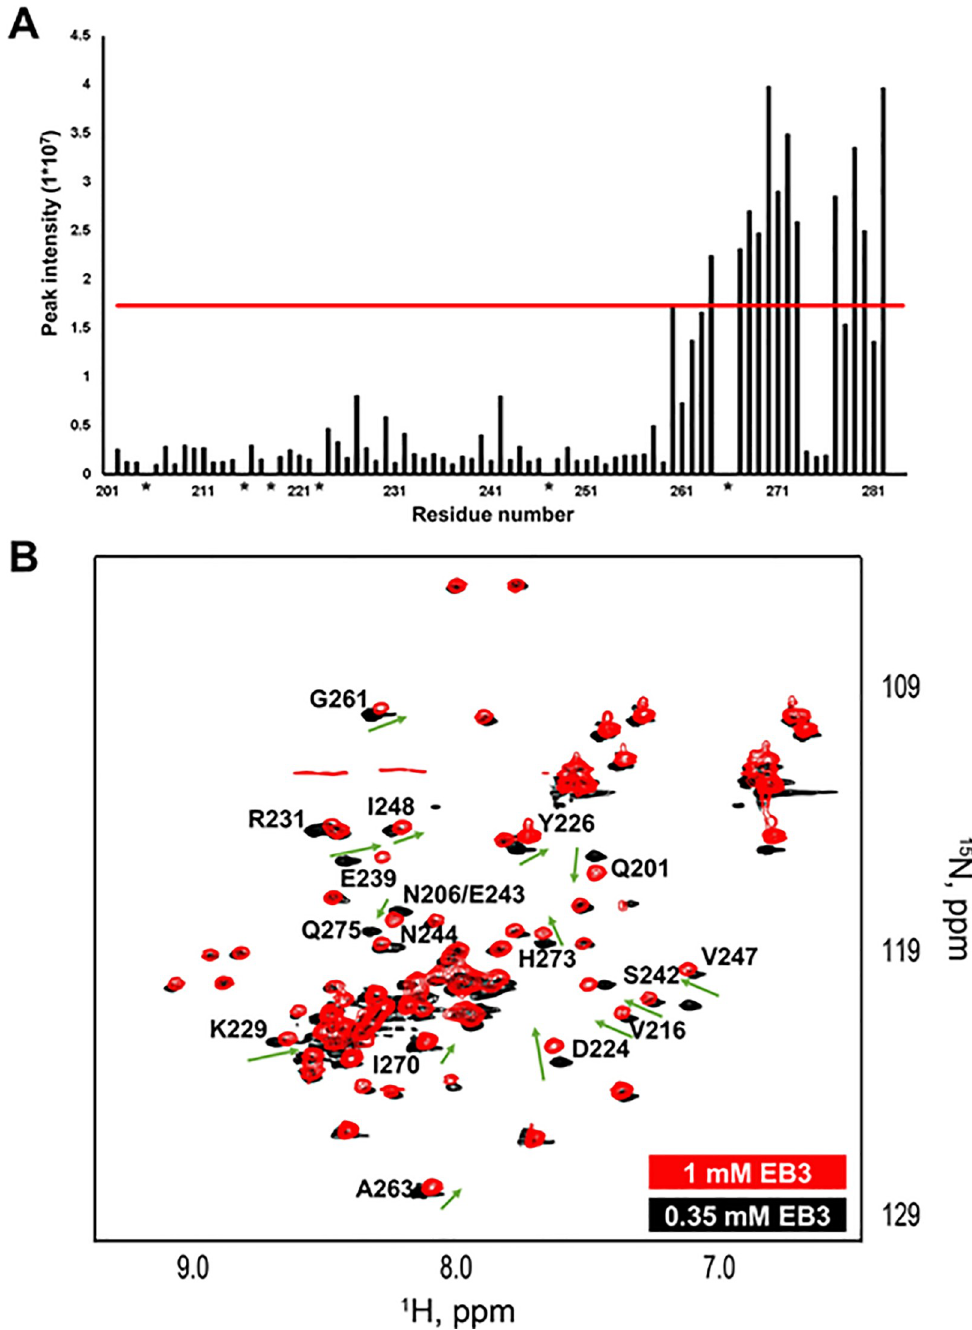
Fig 6. Dynamic Nature and flexibility of the EB3 C-terminal domain. A ) Analysis of NMR amide signal intensities for the C-terminal domain of EB3. Significant signal intensities observed within the region of 259 to 281 amino acids suggest flexibility of helix 3. The red line represents the peak intensity mean + one standard deviation. Asterisk signs refer to residues that were not assigned. B ) 1 H, 15 N overlaid HSQC spectra of the C-terminal domain of EB3 at 0.30 mM (Black) and 1mM (red) show a concentration-dependent chemical shift perturbations (residues Q201; N206; V216; D224; Y226; K229; E239; S242; E243; V247; I248; G261; A263; I270; and H273) and signals broadening (residues R231; N244; and Q275). These changes likely reflect enhanced exchange of EB3 chains at increased protein concentrations. Green arrows show the directionality of the chemical shift change.